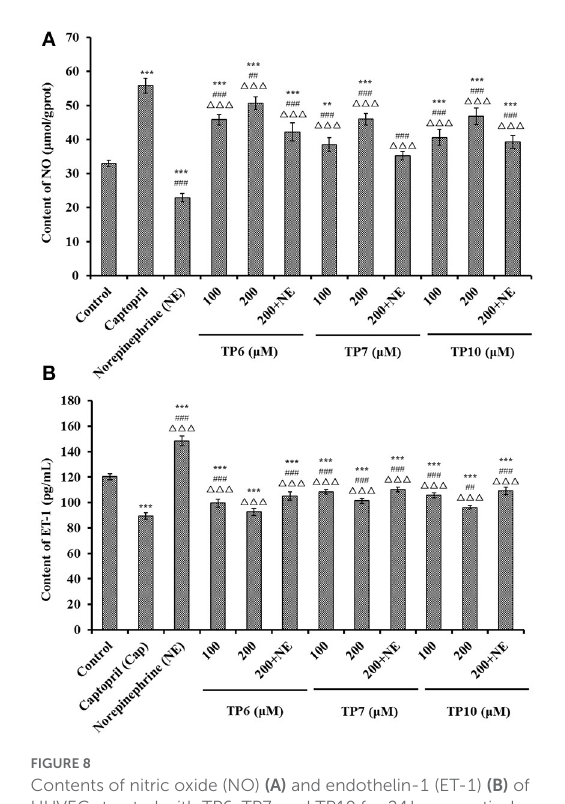
FIGURE8 Contents of nitric oxide (NO) (A) and endothelin-1 (ET-1) (B) of HUVECs treated with TP6, TP7, and TP10 for 24h, respectively. The cell group treated with captopril (Cap) was designed as the positive control. *** P < 0.001 vs. control; ### P < 0.001 and ## P < 0.01 vs. captopril; 111 P < 0.001 vs. norepinephrine (NE).